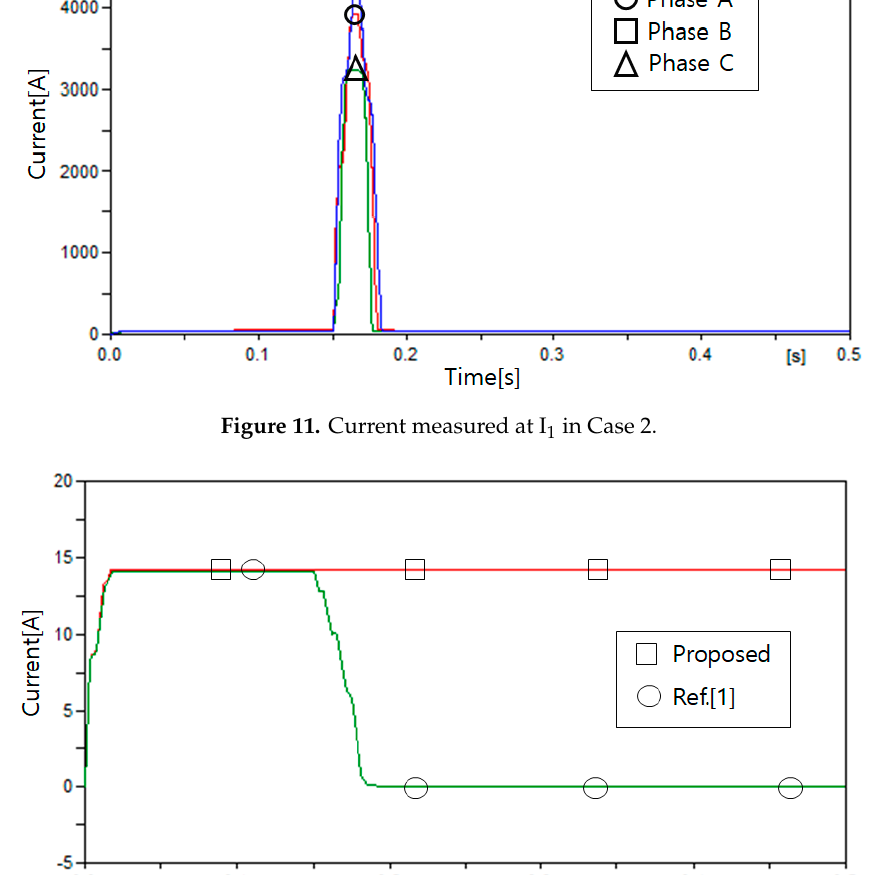
Figure 12. Current measured at Load 3 in Case 2.